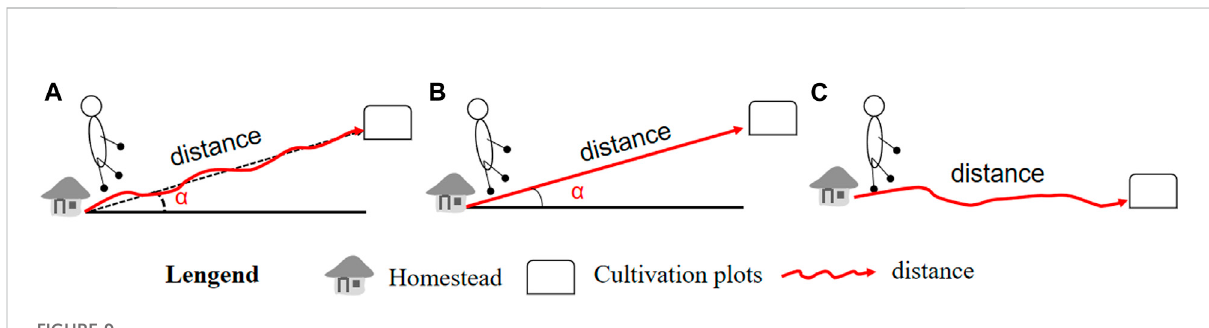
FIGURE 9 Roadaccessibilityindexforthreedifferentscenarios. (A) indicatesascenariowhereroadnetworkdistancesandterrainslopeareconsidered, (B) indicates a scenario where straight-line distances and terrain slope are considered, and (C) indicates a scenario where road network distances are considered but terrain slope is not considered.